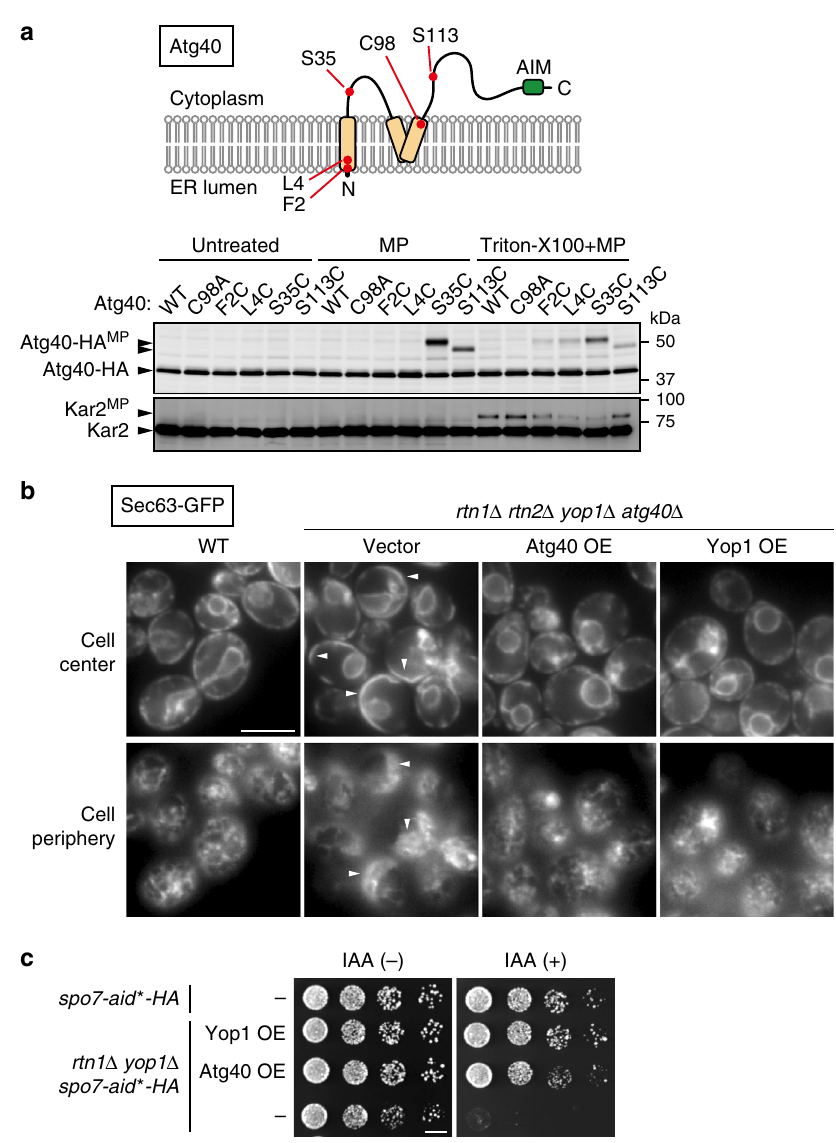
Fig. 1 Atg40 is a reticulon-like protein. a Membrane fractions prepared from yeast cells expressing Atg40 mutants were treated with MP in the presence or absence of Triton X-100. The samples were analyzed by immunoblotting using antibodies against HA and Kar2. Atg40-HA MP , MP-modi fi ed Atg40-HA. The ER lumenal protein Kar2 served as a control. Kar2 MP , MP-conjugated Kar2. b ER morphology was analyzed by fl uorescence microscopy. Images were focused on the center or periphery of the cells. Arrowheads indicate abnormally expanded ER sheets. c spo7-aid*-HA cells were grown on YPD agar plates in the presence or absence of IAA. The experiments were repeated independently twice ( a , b ) or three times ( c ). Scale bars: 5 μ m ( b ), 5 mm ( c